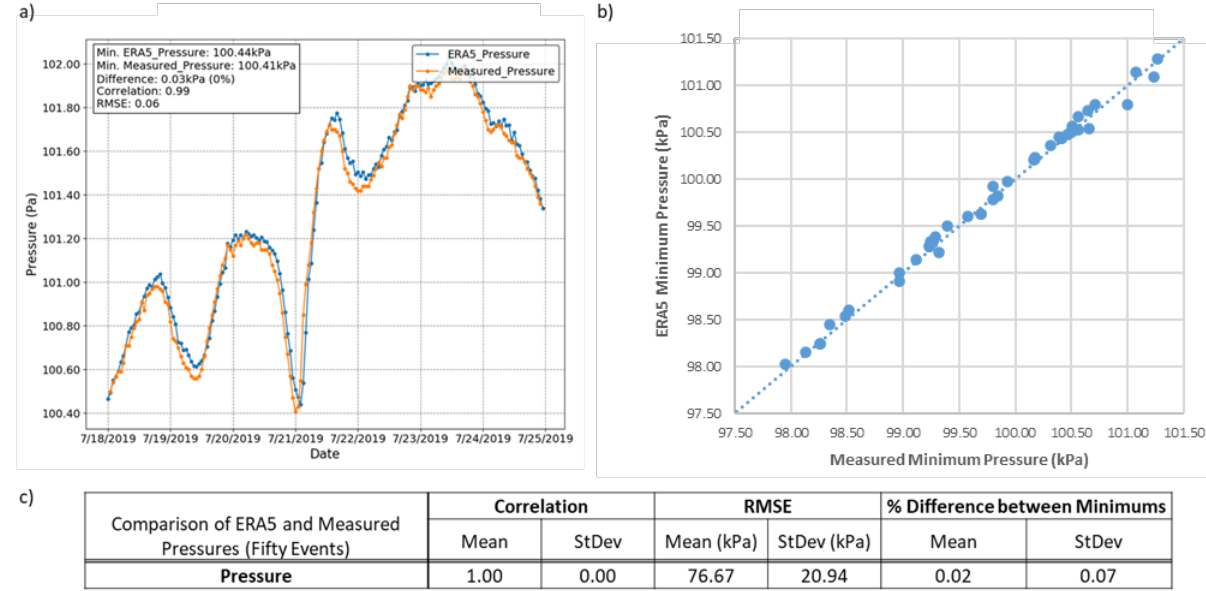
Figure 7. ERA5 surface pressure: ( a ) a direct comparison of the surface pressure field for the largest simulated surge event (July 2019); ( b ) measured vs. modelled minimum surface pressures for all 50 surge events; ( c ) the mean and standard deviation for the correlation, root-mean-squared error (RMSE), and % difference between the minimums for all fifty surge events.